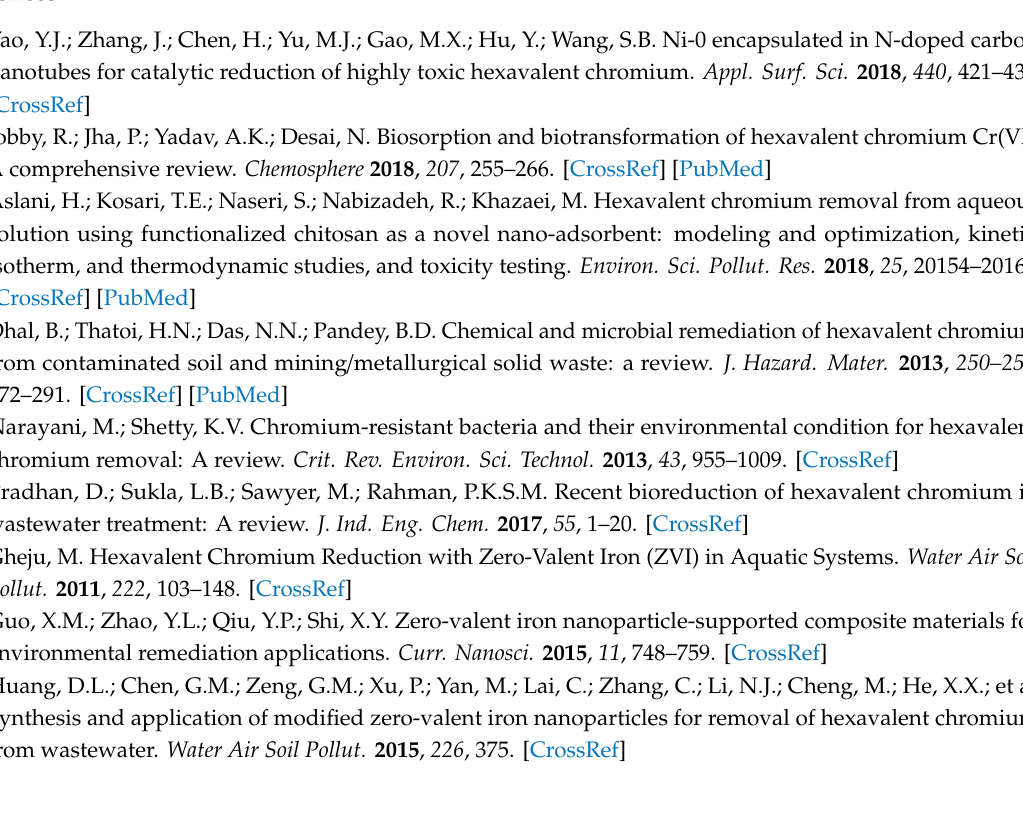
Figure S1: Photograph of the filter paper without (a) and with (b) the assembly of Fe / Pd NPs, Figure S2: Photograph of the K 2 Cr 2 O 7 solution treated with (a) Fe / Pd NP free and (b) Fe / Pd NP-assembled filter paper at di ff erent time